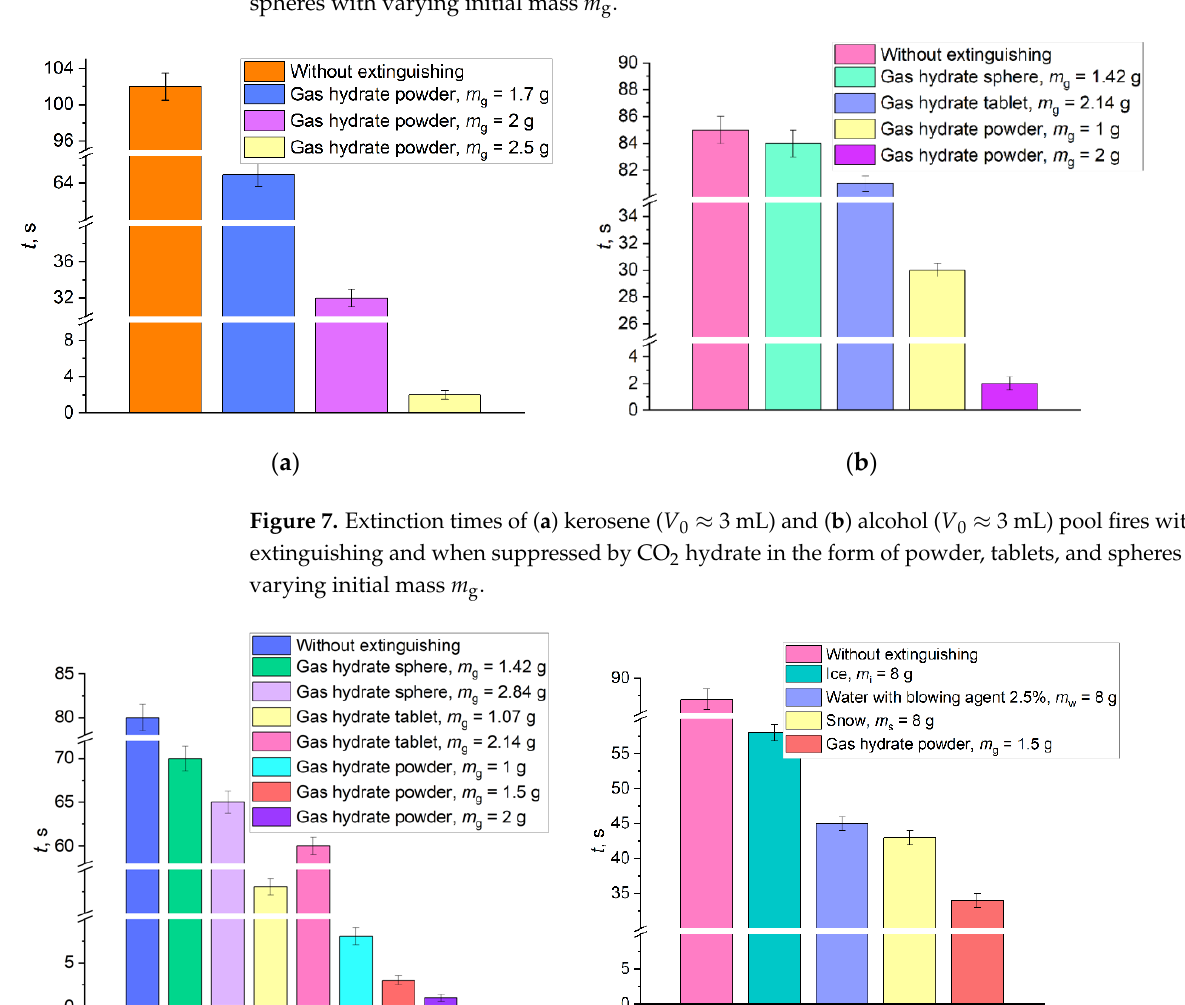
Figure 7. Extinction times of ( a ) kerosene ( V 0 ≈ 3 mL) and ( b ) alcohol ( V 0 ≈ 3 mL) pool fires without extinguishing and when suppressed by CO 2 hydrate in the form of powder, tablets, and spheres with varying initial mass m g .